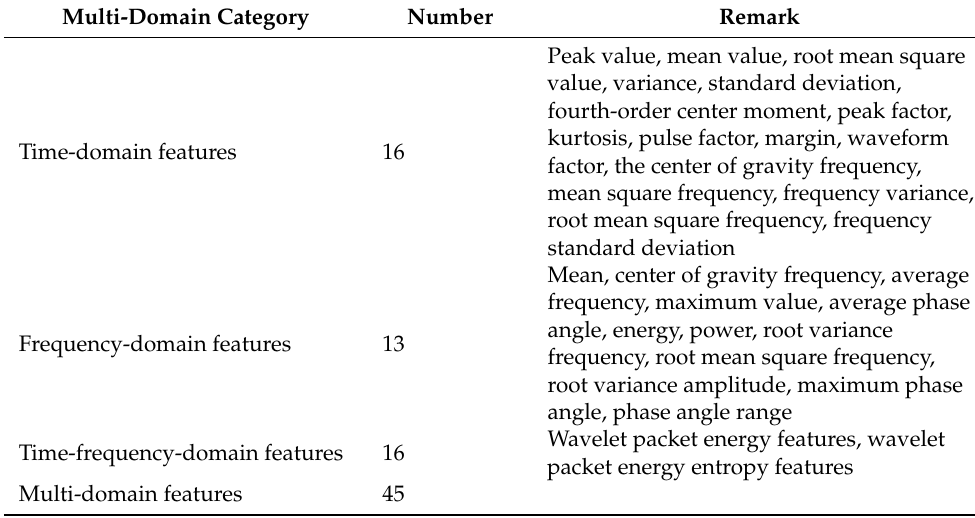
Table 1. Composition of multi-domain feature